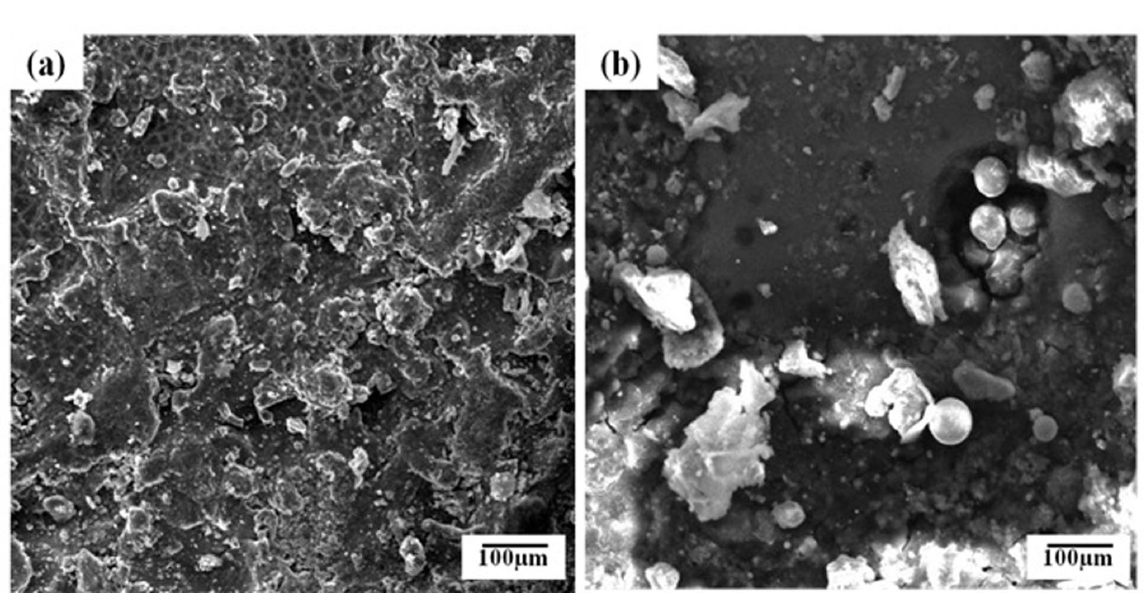
Figure 8: SEM image (a) craters at fully sintered electrode with low pulse on time; (b) globules at higher pulse on